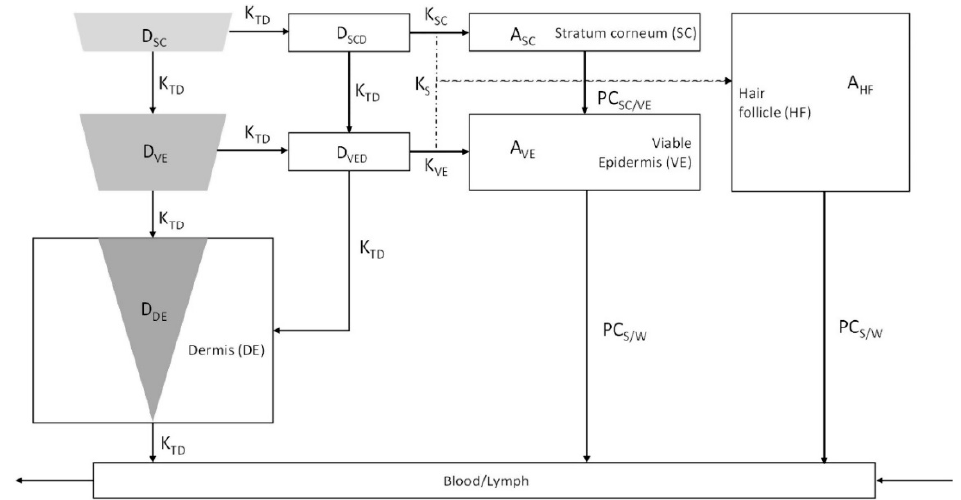
Figure 14. Drug release pathway from the MNs in the intradermal compartment reaching the blood and lymphatic circulation (adopted from [92]). and lymphatic circulation (adopted from